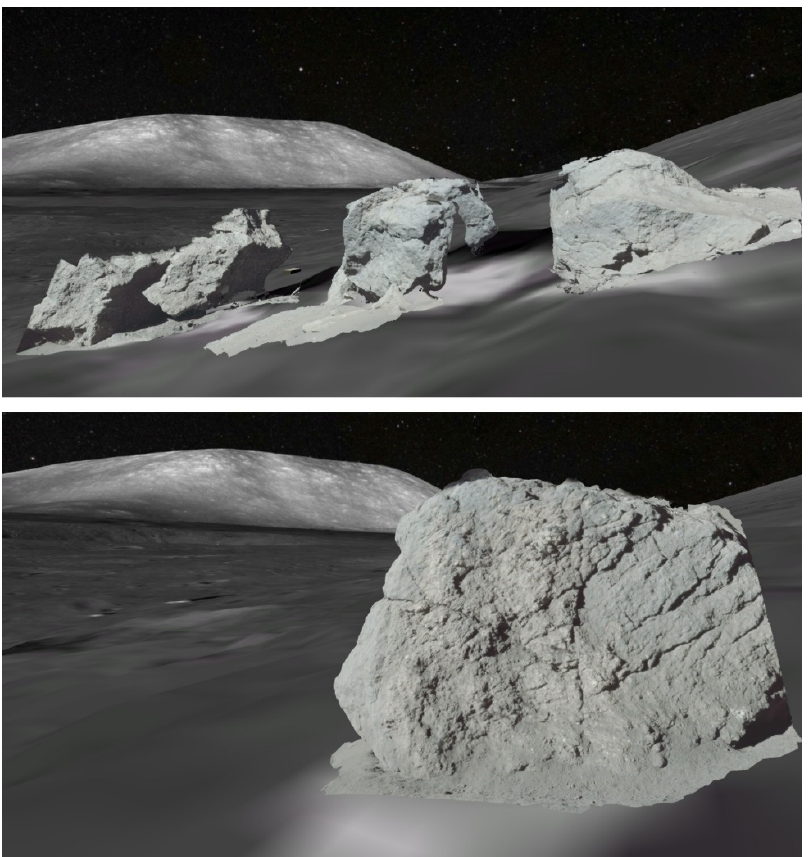
Figure 12. Integration in a game engine, showing a scene composed using 3 ‐ D products derived from both orbital imagery and photogrammetric reconstructions based on in situ photographs of the boulders at Station 6 (up) and Station 7 (bottom). This solution provides insights toward a “VR field geology” characterization of the impact melt boulders in Taurus Littrow.